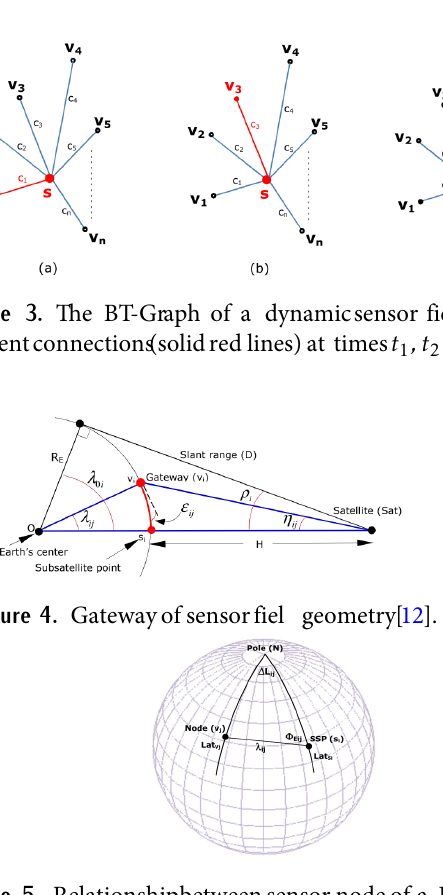
Figure 4. For angular radius of the spherical Earth, ρ i